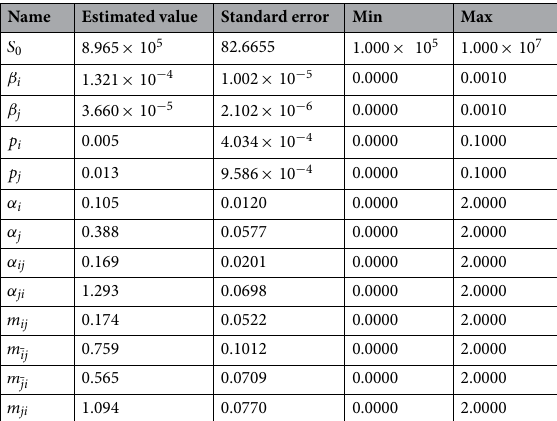
Table 4. Parameter results of two public hot events in Table